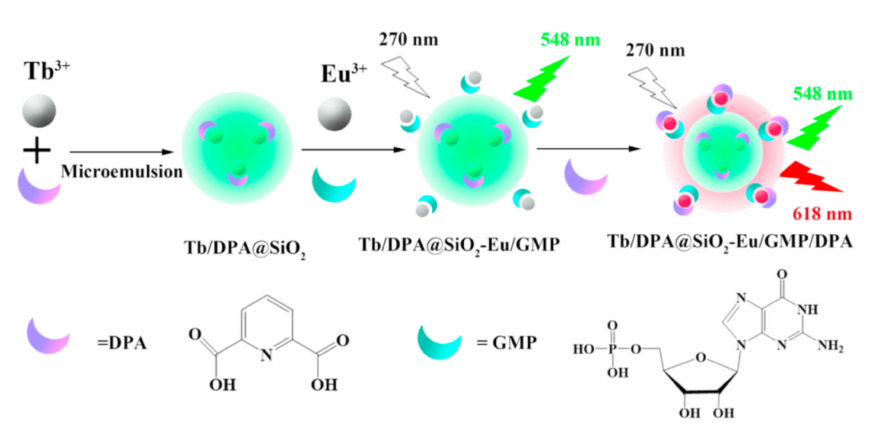
Figure 9. Schematic representation of Tb 3+ /DPA@SiO 2 -Eu 3+ /GMP (Guanosine 5 (cid:48) -monophosphate disodium salt) fluorescent probe formation. DPA, dipicolinic acid. Reproduced from Ref. [91] with permission from the